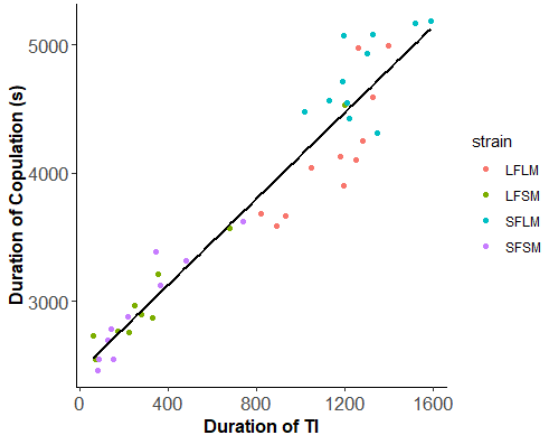
Figure 9. The relationship between the duration of TI and copulation in male SPWs. The four colors indicate different treatments: red—LF and LM; green—LF and SM; blue—SF and LM; purple—SF and SM (y = 2460 + 1.68T ti , R 2 = 0.92).